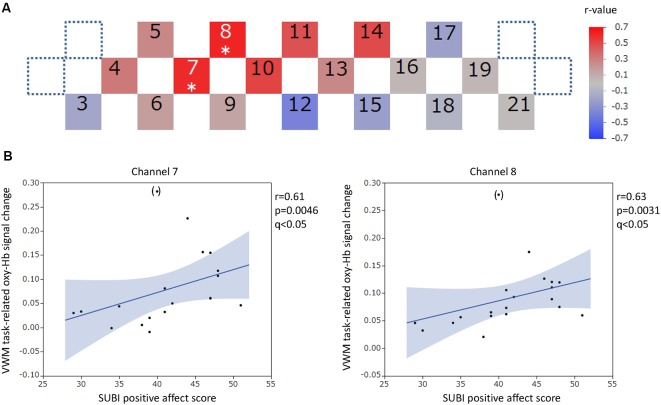
VWM task-related oxy-hemoglobin signal changes and the SUBI positive affect score. Levels of correlation are illustrated by colored squares (A). The color spectrum bar indicates the r-value scale. Channels with statistical significance even after false discovery rate (FDR) correction are indicated by an asterisk (q < 0.05). Scatter plots with a regression line and 95% confidence interval represent the significant channels (B). Outliers are indicated in parentheses. VWM, Verbal working memory; SUBI, Subjective Well-Being Inventory; oxy-Hb, oxy-hemoglobin.